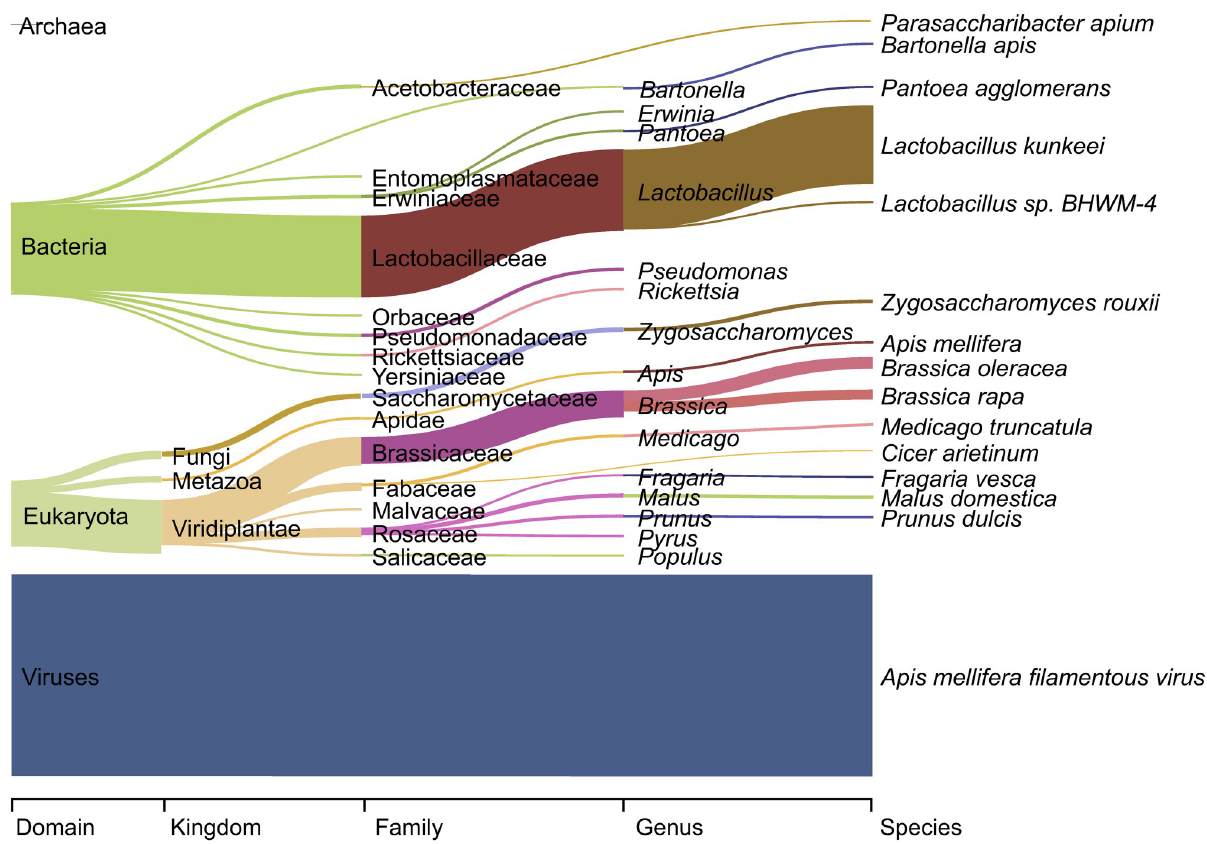
Fig 2. Sankey diagram of the most abundant taxa detected by DNA metagenomics in North-European honey samples. The width of the bar is proportional to the mean RRA of the taxa, with the fifteen taxa with the highest mean RRA shown at each taxonomic level. The graph was created with Pavian